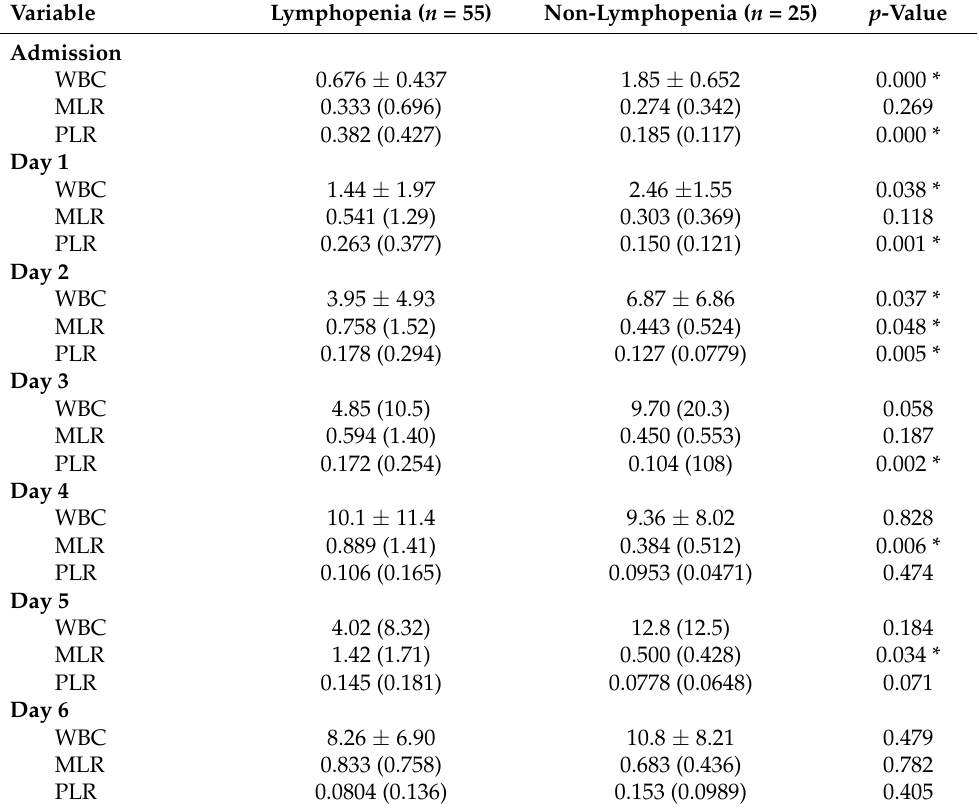
Table 2. The difference in WBC count, MLR, and PLR among test groups at different follow up